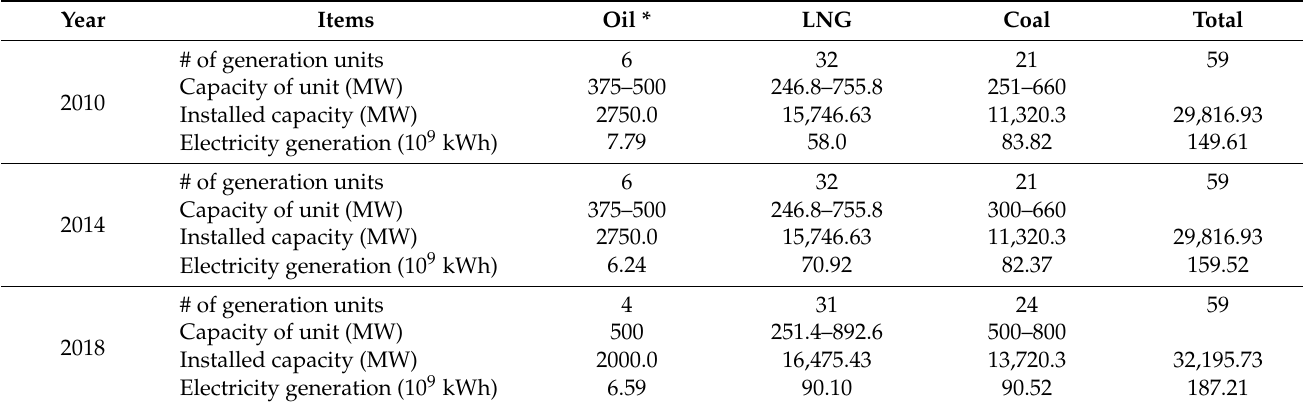
Table 1. Profiles of fossil-fuel power generation capacity in Taiwan [31].